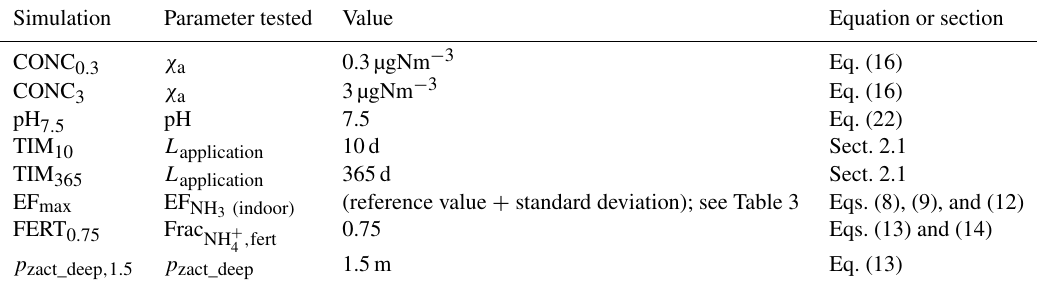
Table 5. Summary of the simulations performed and the parameters tested. The EF NH and storage emissions. The equations and sections related to the individual parameters are also